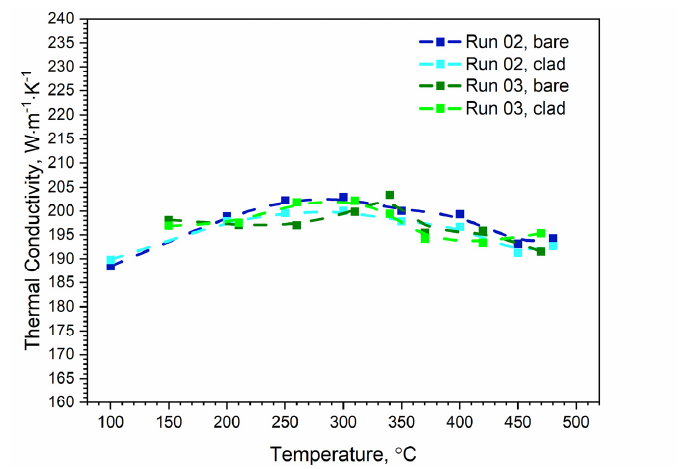
Figure 15. Comparison of the thermal conductivity of bare and clad AW-2024-T3 obtained from LFA